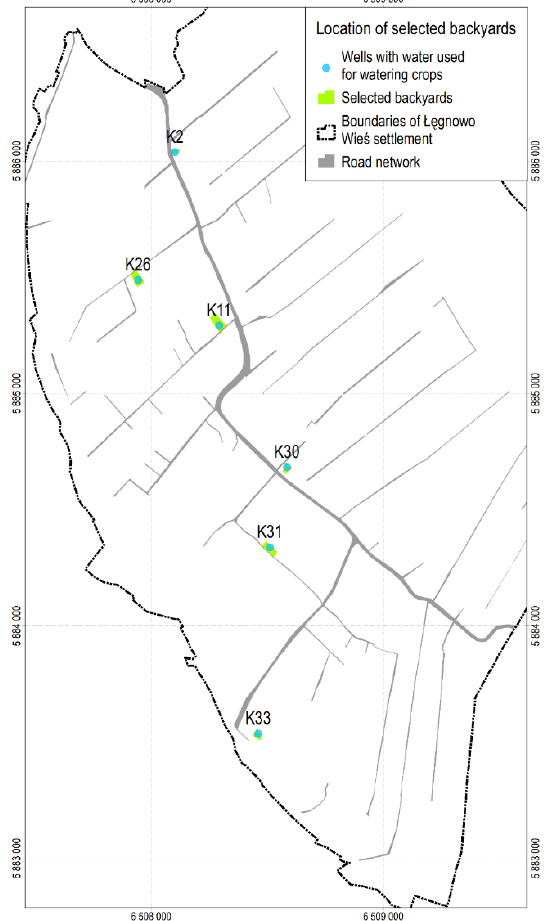
Figure 5. Location of backyards with marked wells. Table 3. Substances determined in the surface soil of the backyards, assigned to the sector and